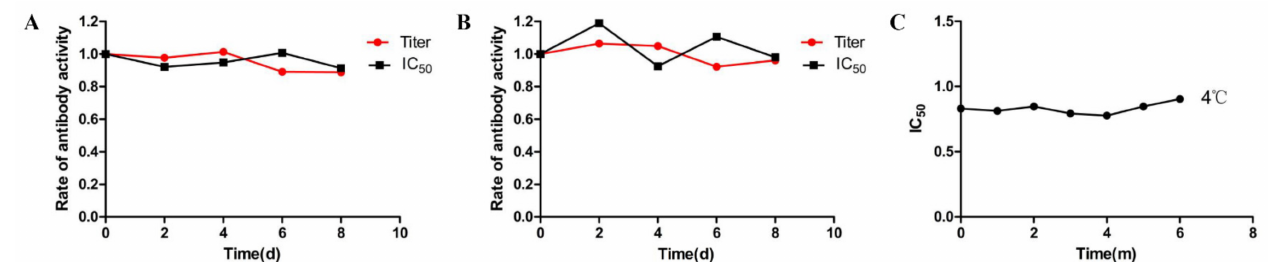
Figure 5. Stability testing of DMEQ–AOAA–OVA coating antigen ( A ), antibody ( B ), and DMEQ standard solution ( C ).